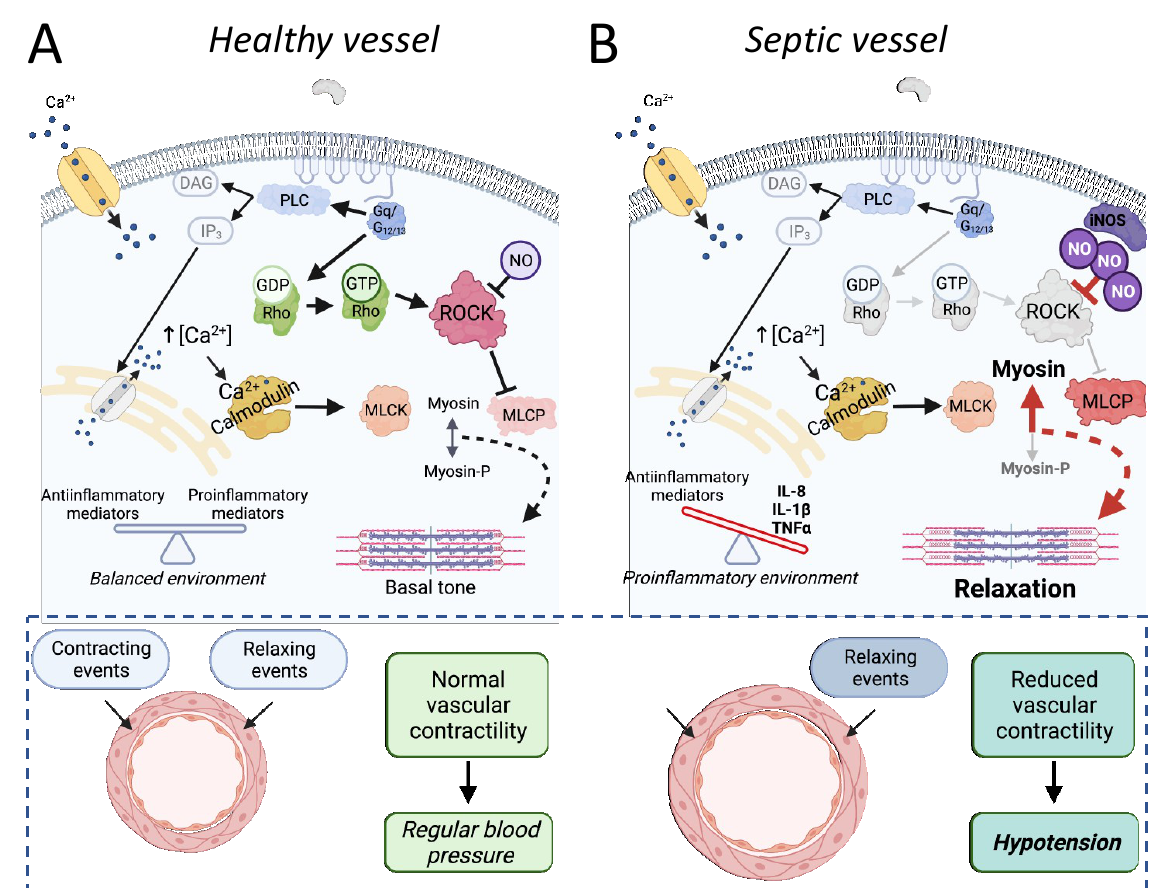
Figure 3. The involvement of Rho proteins in sepsis-associated reduced vascular dysfunction. In healthy vessels ( A ), activation of the RhoA/ROCK pathway functions as a calcium sensitization mechanism, crucial for regulating vascular tone. Once activated by RhoA, ROCK inhibits the myosin light chain phosphatase (MLCP) activity, maintaining balanced levels of phosphorylated myosin and the vascular tone. Under physiological conditions, there is an equilibrium between contracting and relaxing events, resulting in normal vascular contractility and normal blood pressure. In septic vessels ( B ), the proinflammatory environment and high levels of nitric oxide, among other factors, reduce the effectivity of Rho- mediated calcium sensitization, as illustrated by the grayscale of RhoA/ROCK pathway components and arrows. The final result is an augmented MLCP activity and less phosphorylated myosin (Myosin-P), contributing to the loss of vascular tone and relaxation of vessels. Under septic conditions, the relaxing events are enhanced, and the reduced vascular contractility in resistance arteries is one of the main causes of hypotension. Importantly, the absence of changes in other components included in the scheme (i.e., membrane receptors, calcium levels) does not mean that they are not compromised in sepsis. PLC, phospholipase C; DAG, diacylglycerol; IP3, phosphatidylinositol 1,4,5-trisphosphate; MLCK, myosin light chain